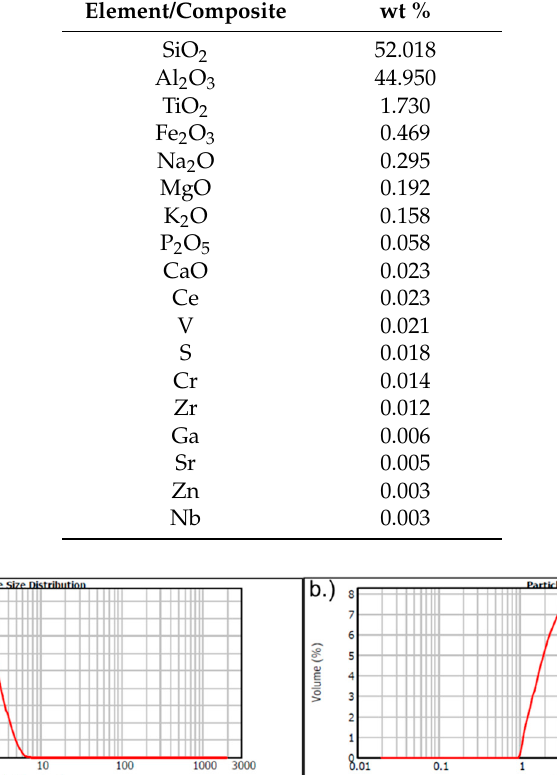
Table 1. Chemical composition of the precursor (MK).